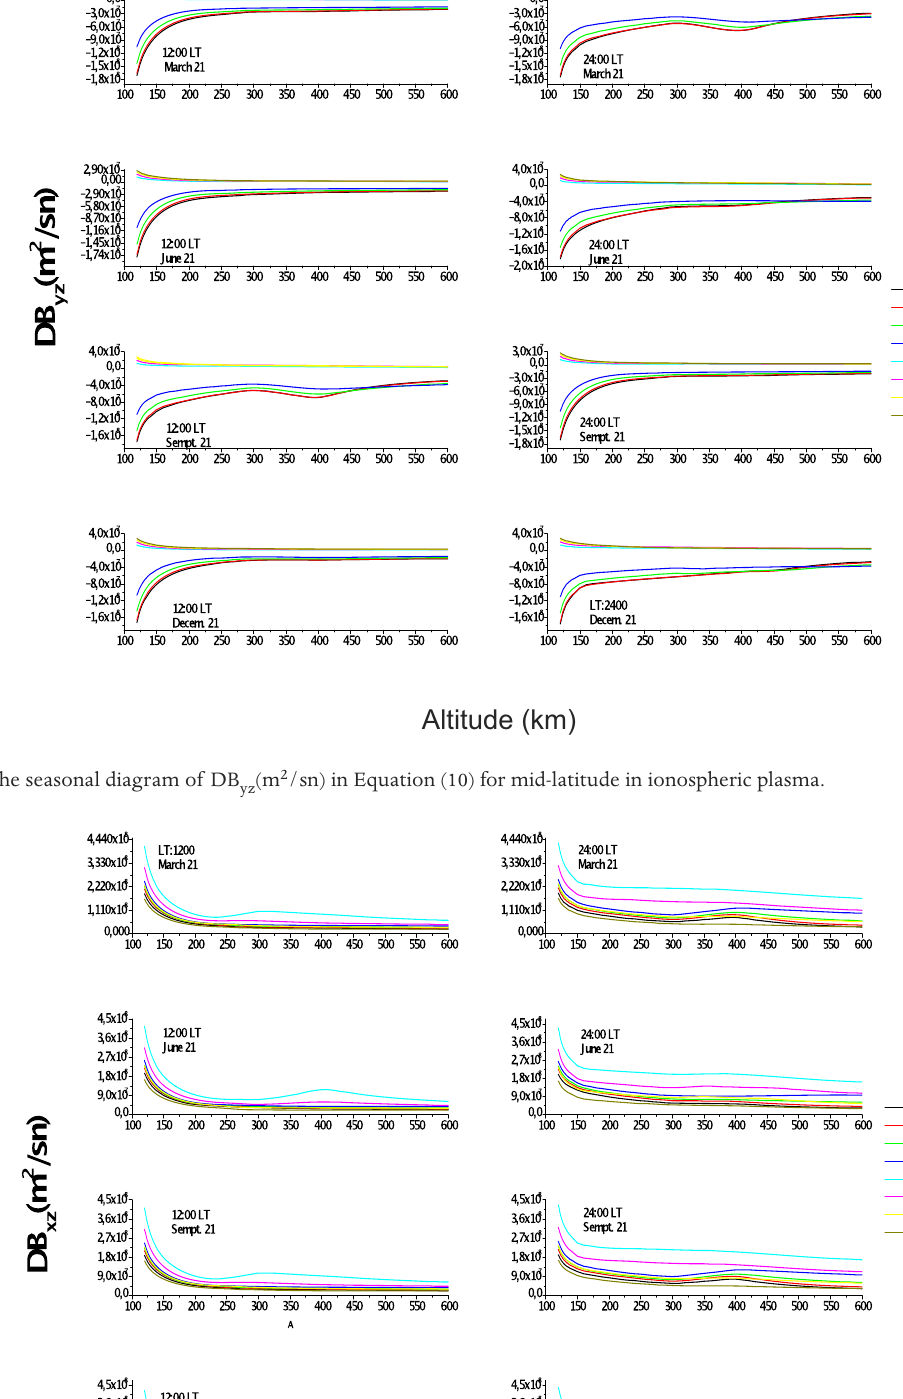
(m 2 /sn) in Equation (10) for mid-latitude in ionospheric xz